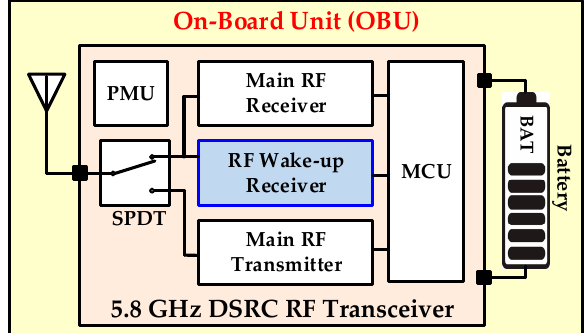
Figure 2. The DSRC OBU system level block diagram.